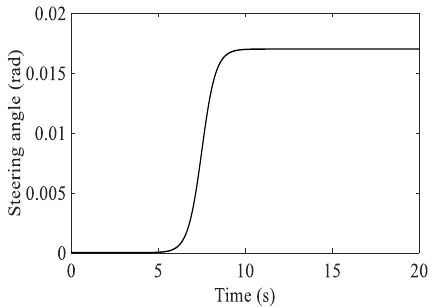
Figure 3. Front-wheel steering angle.